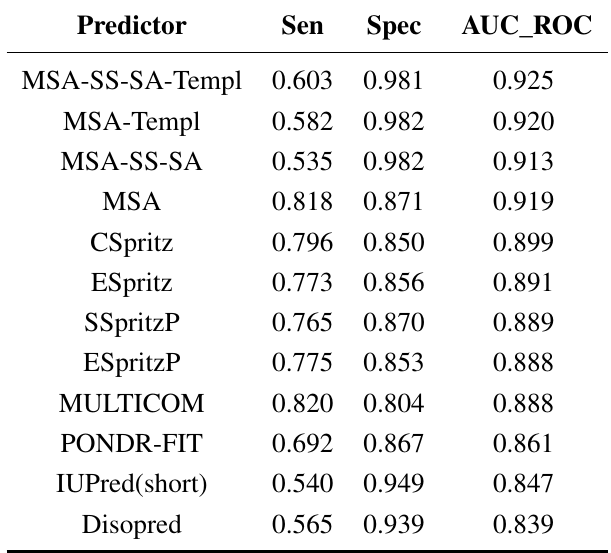
Table 5. Results for Sens, Spec and AUC on X-ray test sets for all of our systems and the top-ranking methods as reported in Walsh et al. (2012) [34].